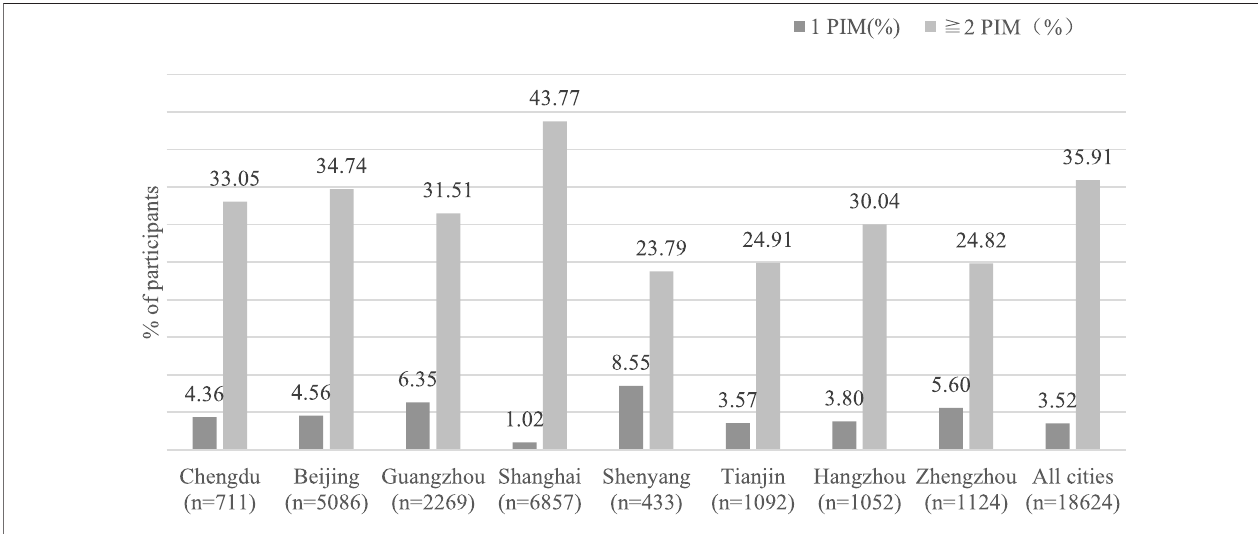
FIGURE 1 | Prescription of 1 PIM and ≥ 2 PIMs among older outpatients with dementia in